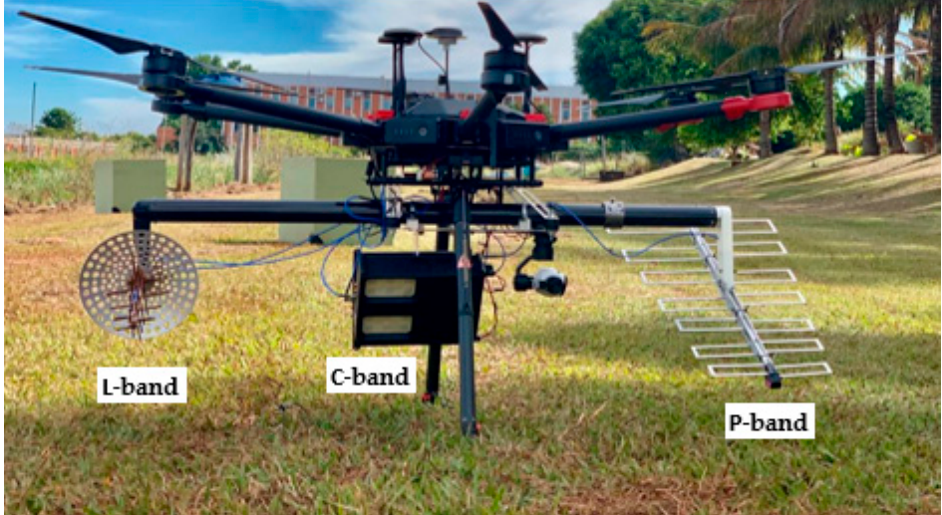
Figure 1. Image of the drone-borne SAR with the L-band, the P-band and the two C-band antennas. The Motion Sensing System (MSS), which includes a single channel GNSS receiver and an inertial measurement unit (IMU), is integrated into the radar, as shown in [12]. There is also a ground station with a single channel GNSS, to provide differential GNSS processing.